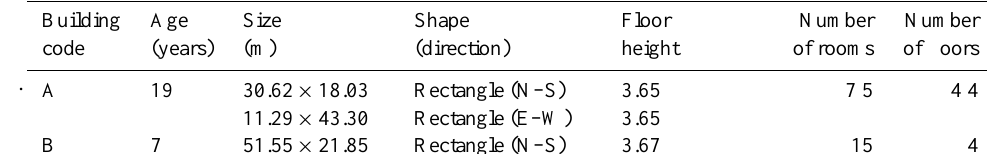
Table 1. Characteristics of the TEI buildings at Chania